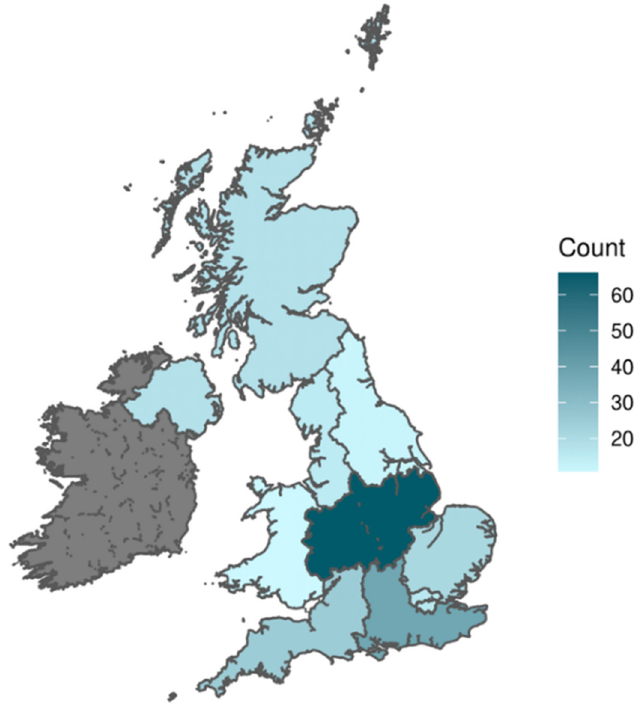
Figure 2. Count of respondents per region .